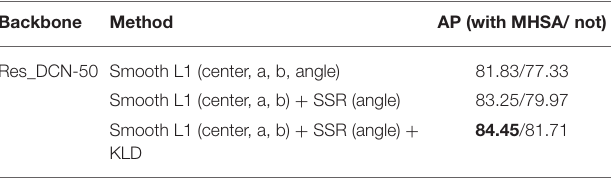
TABLE 2 | Ablation experiments results.